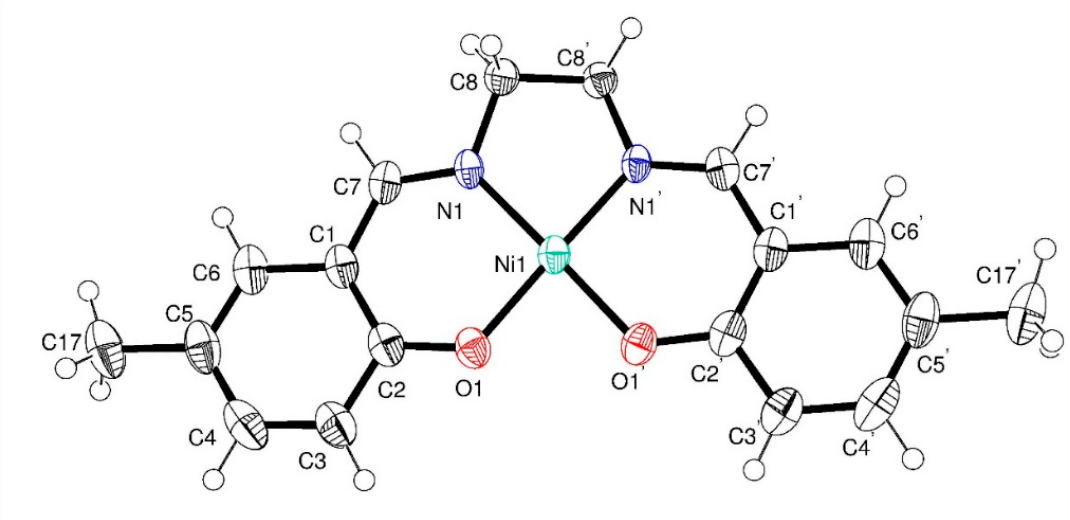
Figure 1. View on the perspective of the compound NiMe salen, with a displacement ellipsoid at a 50% probability level for non-H atoms.